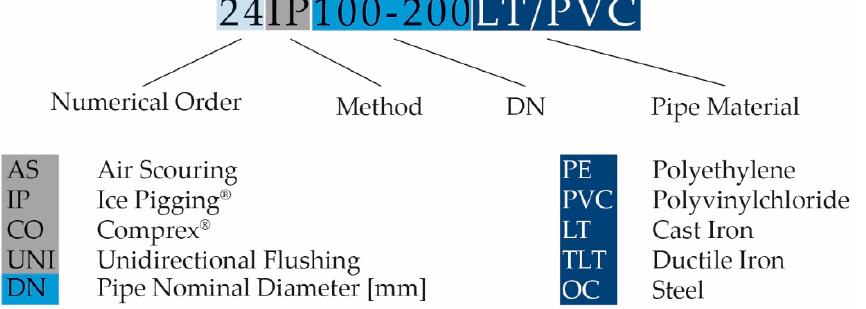
Figure 1. Code characterizing the experiments’ numerical order and cleaning conditions-used method, pipe nominal diameter and pipe material (in case of one cleaned section is created by more types, e.g. a hyphen (-) divides particular pipe nominal diameters and a slash (/) divides used types of pipe materials).